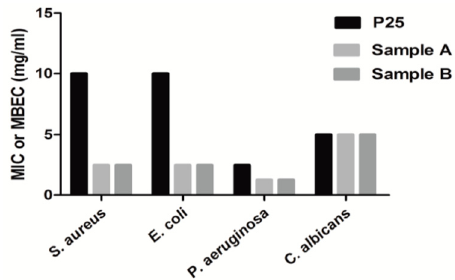
Figure 28. MIC and MBEC values of rGO / 1%Fe-N-doped TiO 2 nanocomposites and commercial P25 TiO 2 treated with S. aureus , E. coli , P. aeruginosa and fungal C. albicans under visible light at 37 °C for 24 h. Reproduced with permission from [277]. Copyright MDPI, 2017.